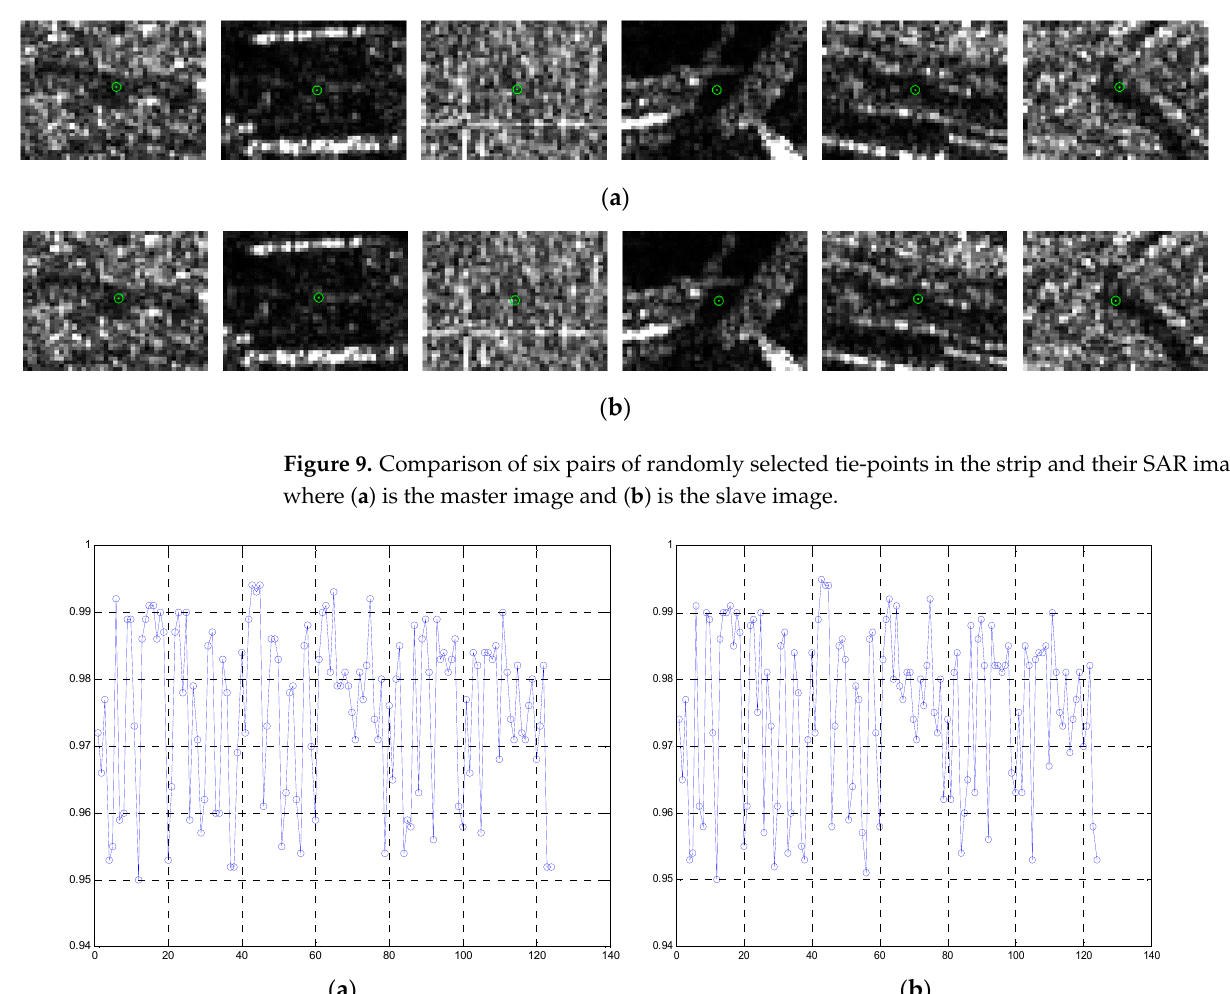
Figure 10. Coherence coefficient of the tie-points in the master and slave SAR images within strips, where ( a ) is the master image and ( b ) is the slave image.